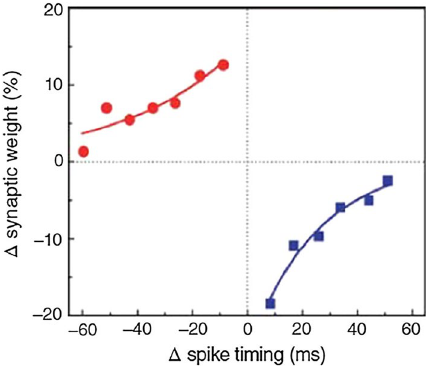
Fig. 28 STDP curve of RRAM device based on experimental data. Reproduced with permission